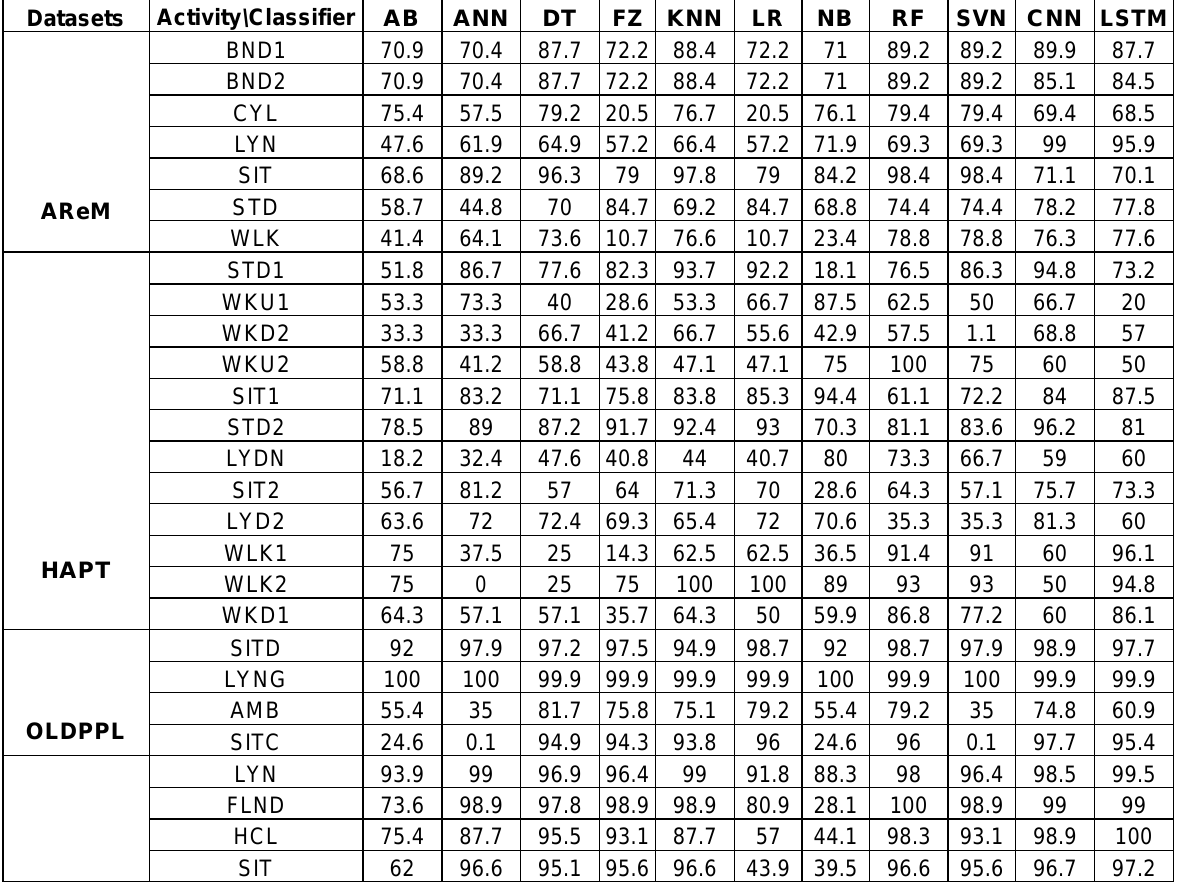
Table 4. Classifier Recall of Activities for all datasets